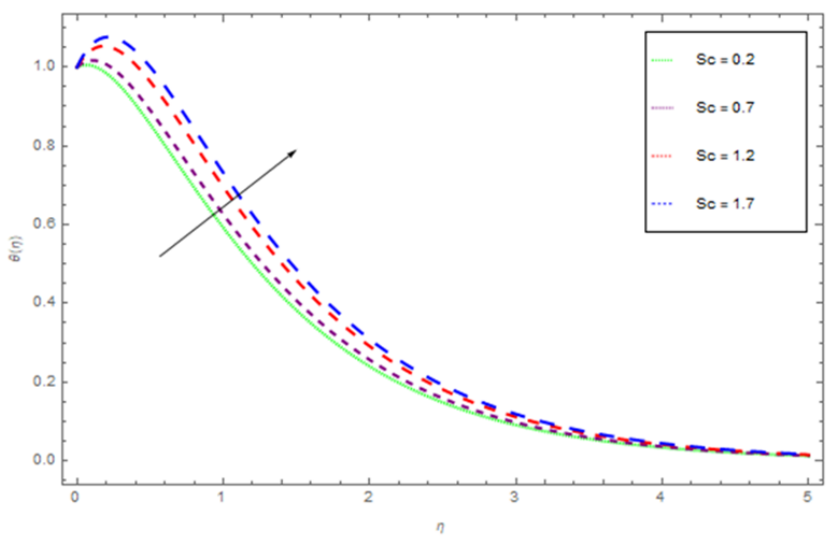
Figure 11. The influence of S c on ( )  , while